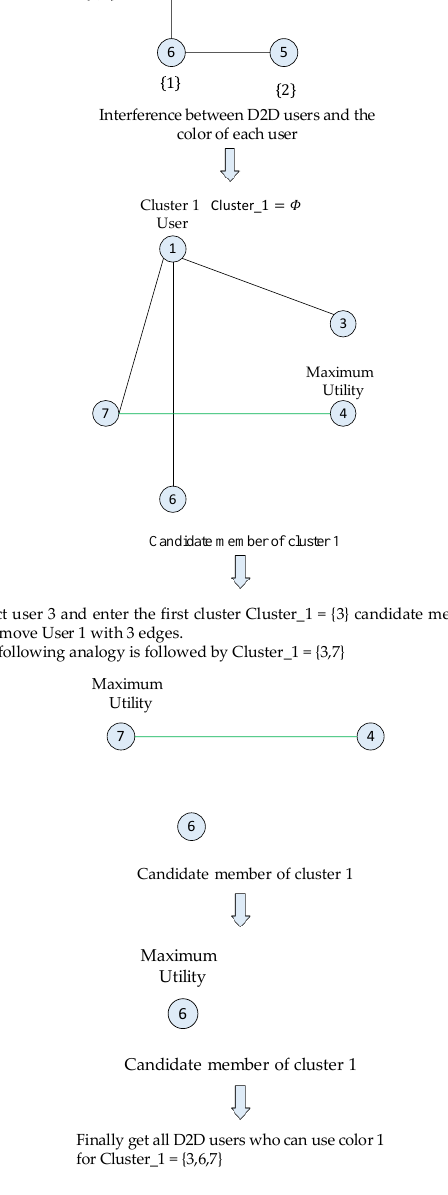
Figure 2. Illustration of the method of clustering.